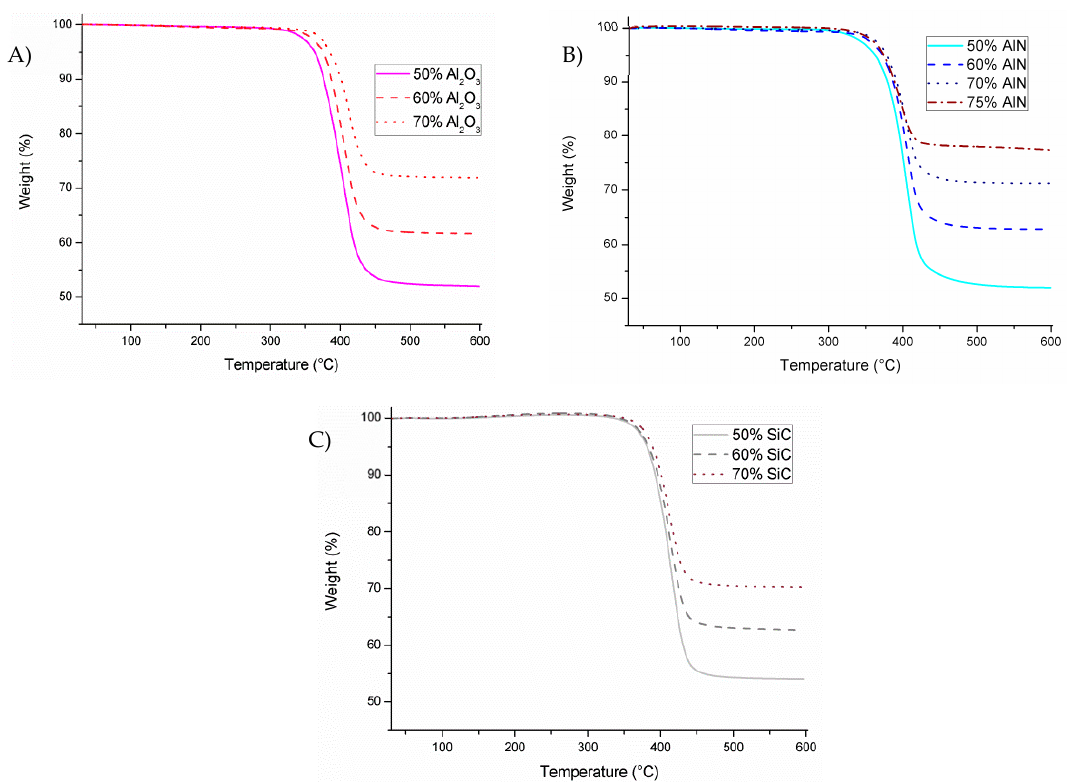
Figure 5. Thermogravimetric analysis (TGA) degradation curves of the different composites obtained by the addition of with different fillers: ( A ) Al 2 O 3 ; ( B ) AlN; ( C ) SiC. Table 2. Thermogravimetric and thermomechanical data from the composites